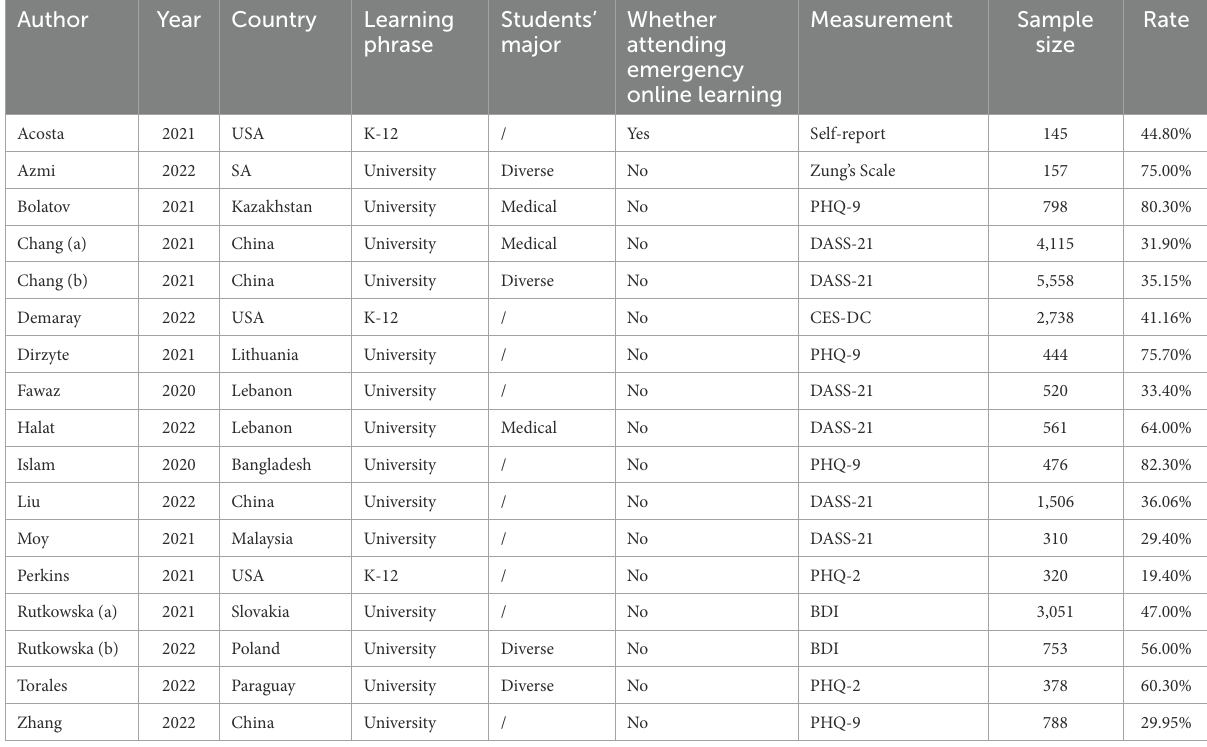
TABLE 2 Summary coding of included depression studies (arranged in alphabetical order of the first